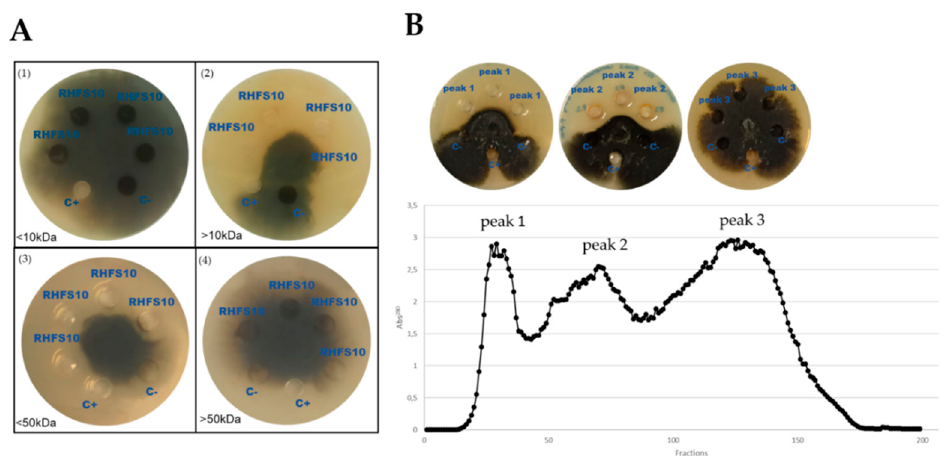
Figure 5. Antifungal activity of cell-free supernatant fractions of RHFS10. ( A ) 72-CFS was size- fractionated using 10, 30 kDa and, 50 kDa cutoff spin columns, and the obtained fractions were tested against M. phaseolina . The results obtained with fractions <10 (1), >10 (2), <50 (3) and >50 kDa (4) are reported. C+: Positive control, pentachloronitrobenzene; C − : negative control, toluene; RHFS10: 0.1 mL of fractionated 72-CFS. ( B ) Elution profile of 72-CFS by fractionation on Sephadex G-50 fine column chromatography. The antagonist activity of the three recovered peaks (1 mg/dot) is reported in the upper part of the panel. All data represent the average of three separate experiments. ANOVA statistical analysis is extremely significant indicated— p < 0.001.